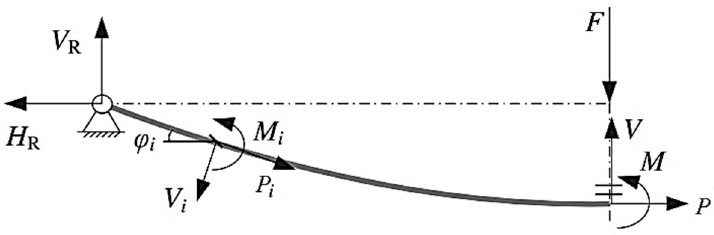
Figure 9. Development of internal forces in the beam-to-column assembly in the case of middle column removal.